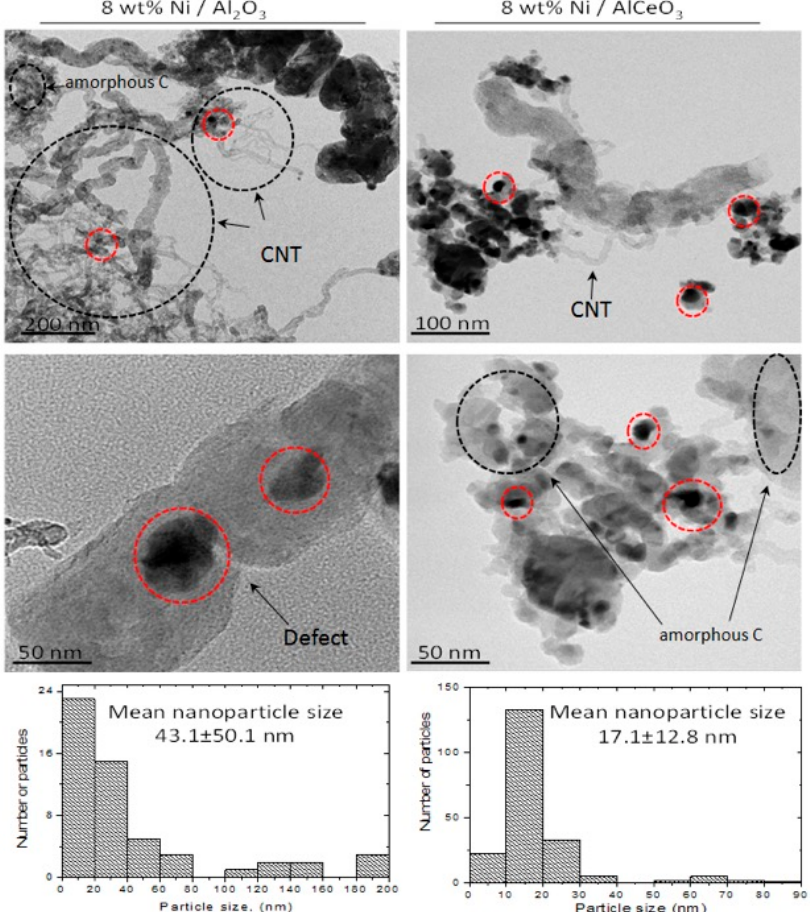
Figure 12. TEM images and particle size distribution of the Ni / Al 2 O 3 and Ni / AlCeO 3 spent catalysts (samples tested under experimental protocol #2).